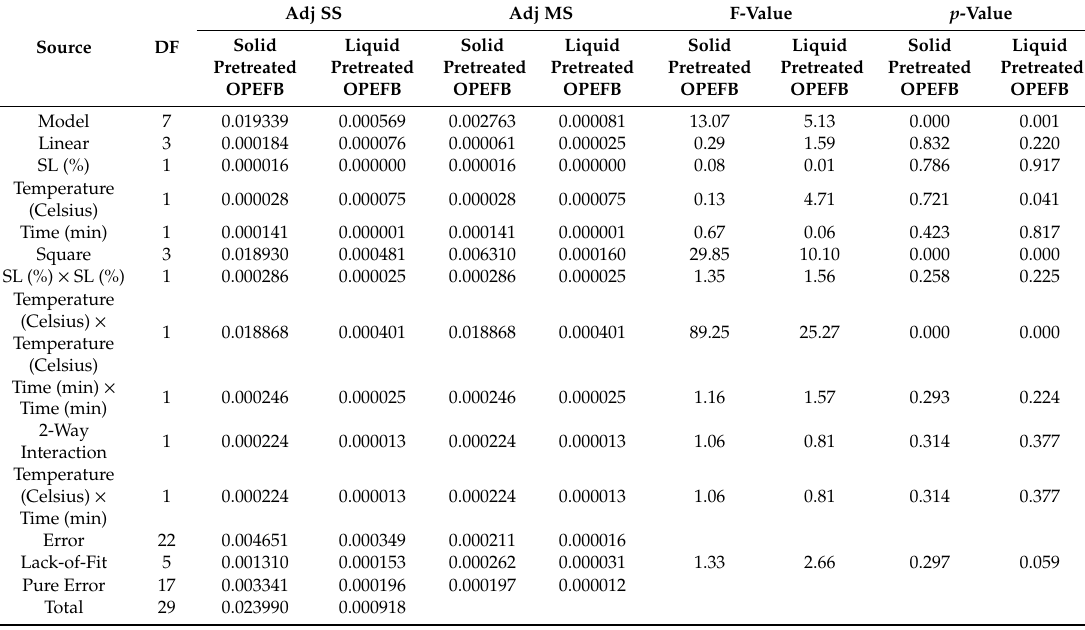
Table 2. Analysis of variance of xylose recovery in the hydrolysate of solid and liquid pretreated